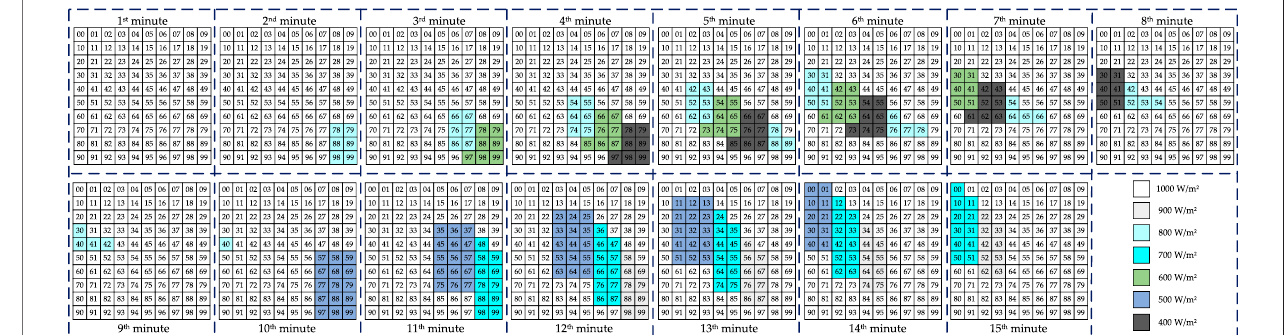
FIGURE 4 | The irradiation distribution for each sub-system of the PV power plant.